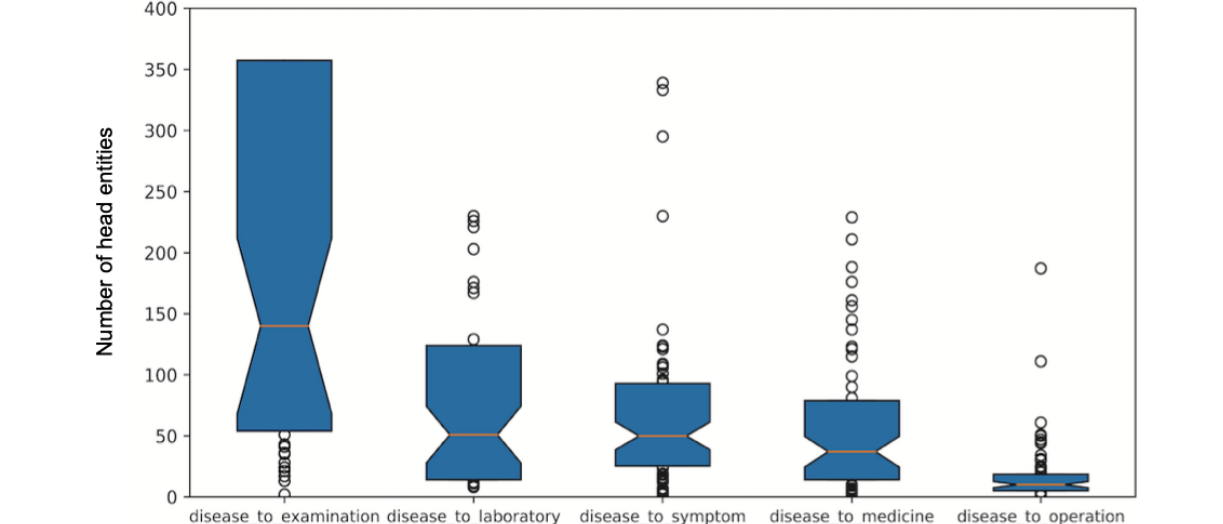
Figure 6. Distribution of head entities numbers by different